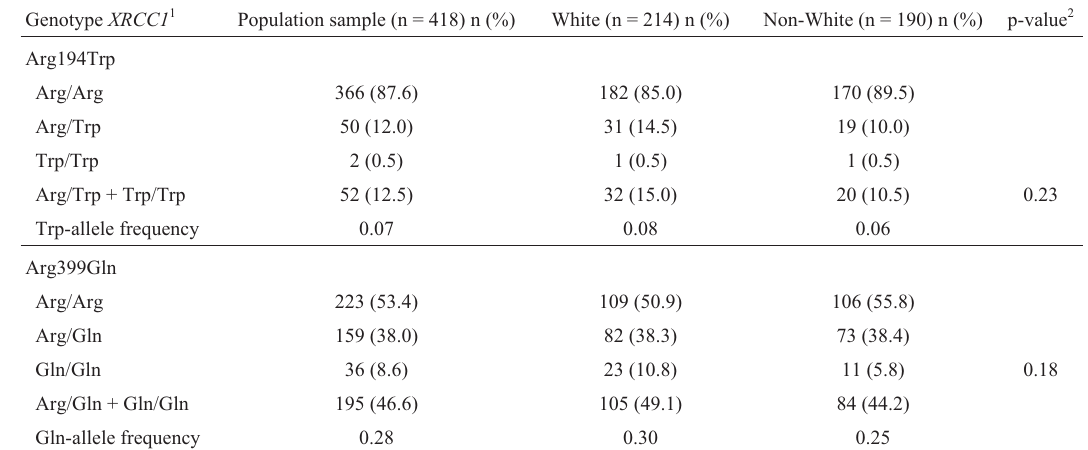
Table 2 - Frequency of polymorphisms XRCC1 -Arg194Trp and XRCC1 -Arg399Gln in the population sample and distribution according to ethnicity.